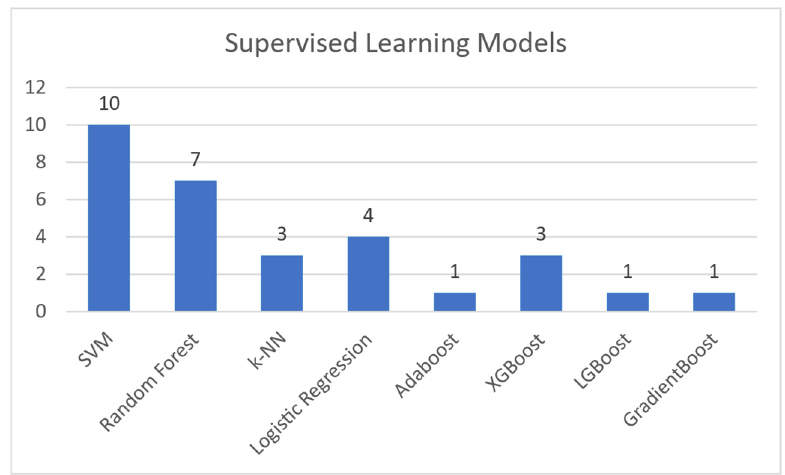
Figure 5. Supervised learning techniques used in misinformation.